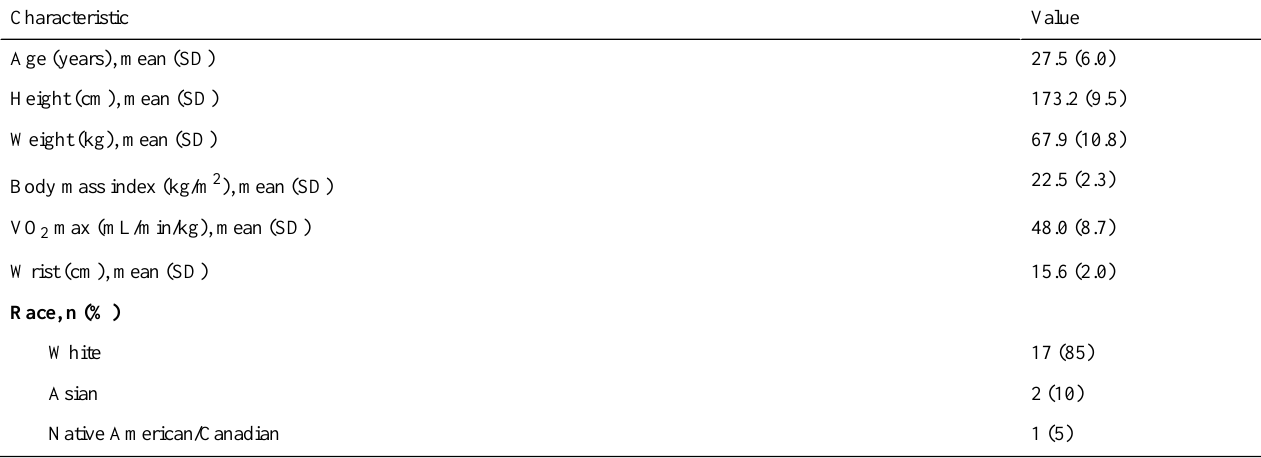
Table 1. Participant characteristics (n=20). VO 2 max (maximal oxygen uptake) was measured at the incremental test to exhaustion.